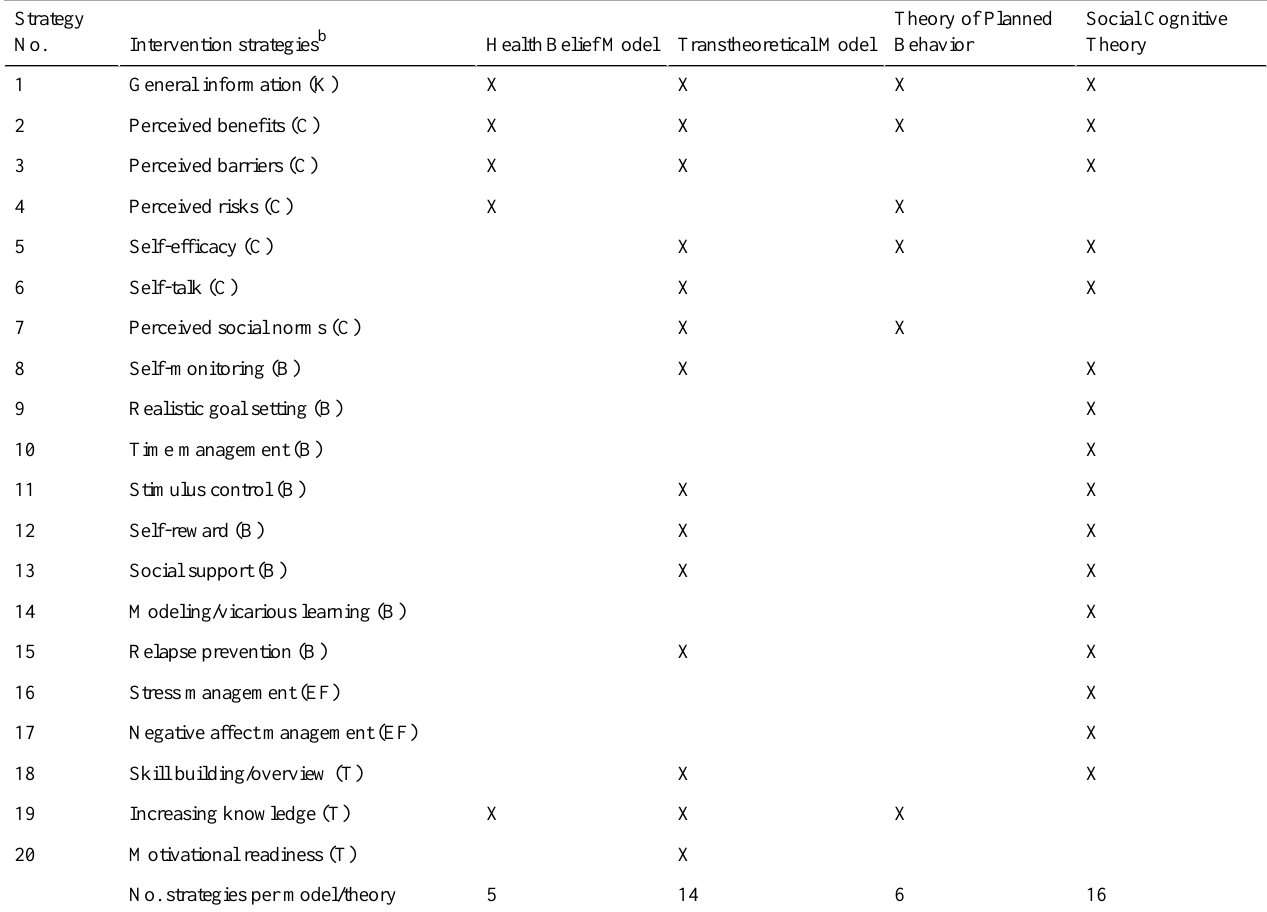
Table 1. Behavioral Theory Content Survey a : intervention strategies by behavior change model or